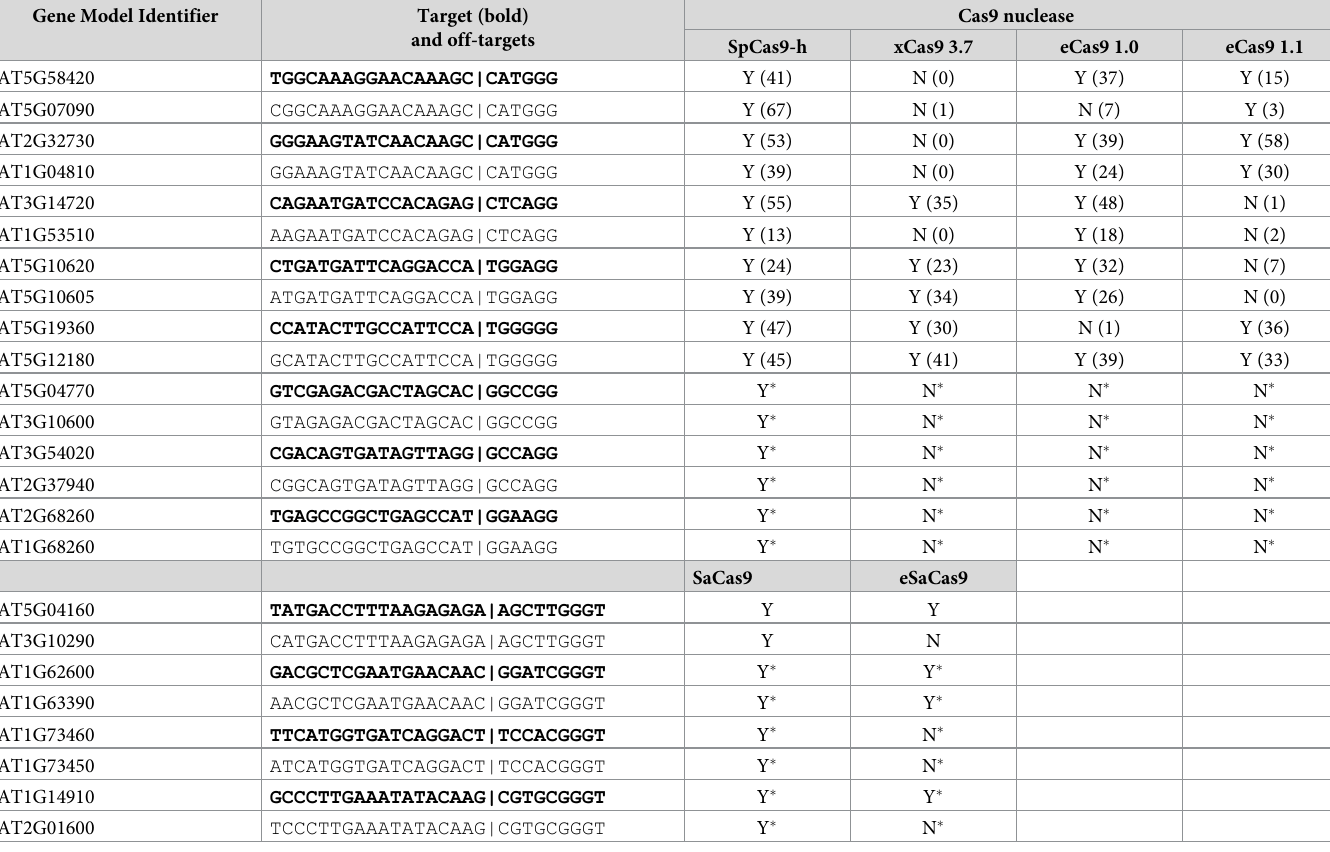
Differences between target (bold text) and off-target pairs are shown in red text. The Protospacer Adjacent Motif (PAM) is shown in blue text. Numbers in parentheses are scores from Inference of CRISPR Editing (ICE) software that quantifies the efficiency of induced mutations at the target from the sequence chromatogram. Y/N indicates that mutations at the target were/were not detected � indicates assessment made by detection of deletion induced with a second sgRNA. | indicates expected point of